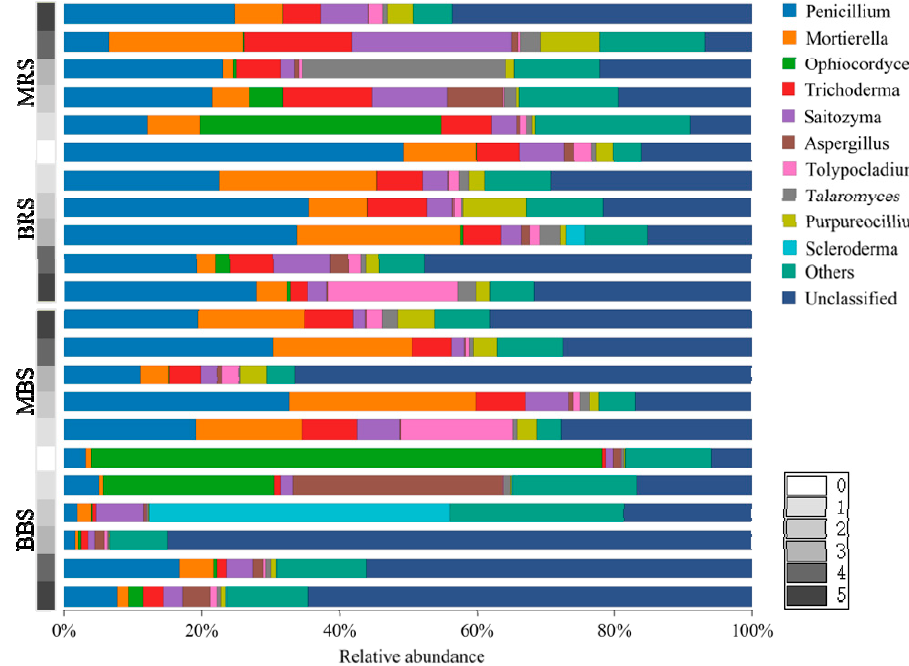
Figure 6. The relative abundances of top 10 main fungal genera. B and M indicate bamboo biochar and bacteria-inoculated biochar; BS and RS indicate bulk soil and rhizosphere soil. 0, 1, 2, 3, 4, and 5 indicate control, 2.22 t · ha − 1 , 4.44 t · ha − 1 , 6.67 t · ha − 1 , 8.89 t · ha − 1 , and 11.11 t · ha − 1 .